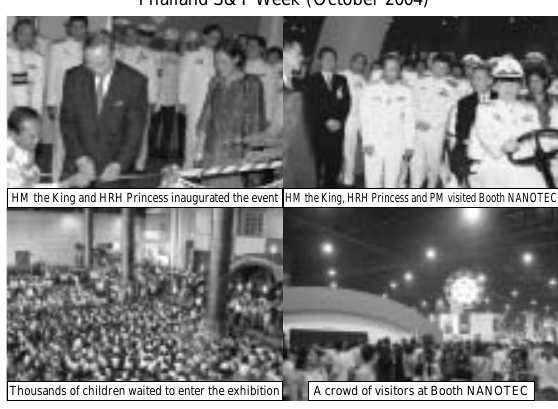
Other Events in